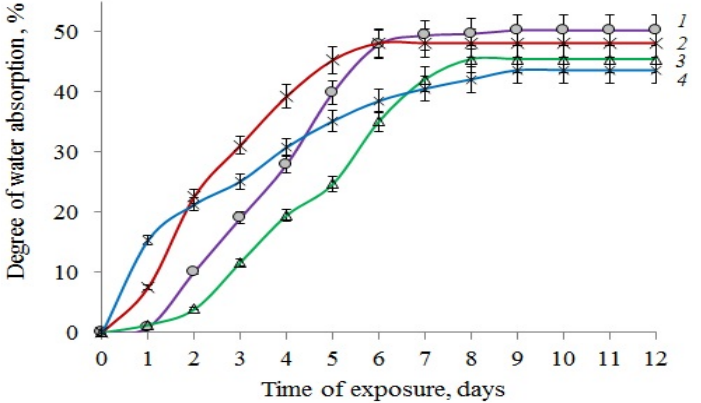
Figure 4. Water uptake of PLA/NR non-woven fibers. The content of NR, wt%: (1) 0; (2) 5; (3) 10; (4)